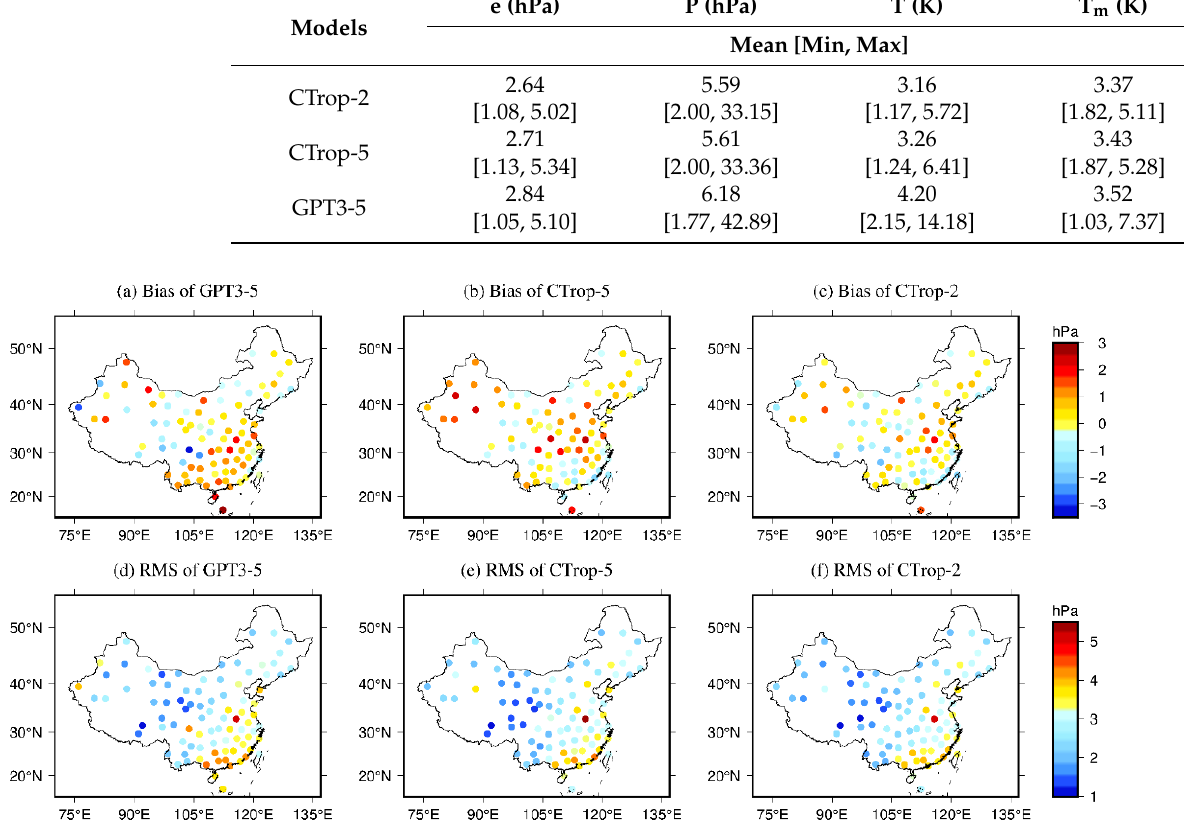
Figure 12. Distribution of the performance of pressure in different resolutions of the CTrop and GPT3 models validated by radiosonde sites in 2017: ( a ) Bias of GPT3-5; ( b ) Bias of CTrop-5; ( c ) Bias of CTrop-2; ( d ) RMS of GPT3-5; ( e ) RMS of CTrop-5; ( f ) RMS of CTrop-2.